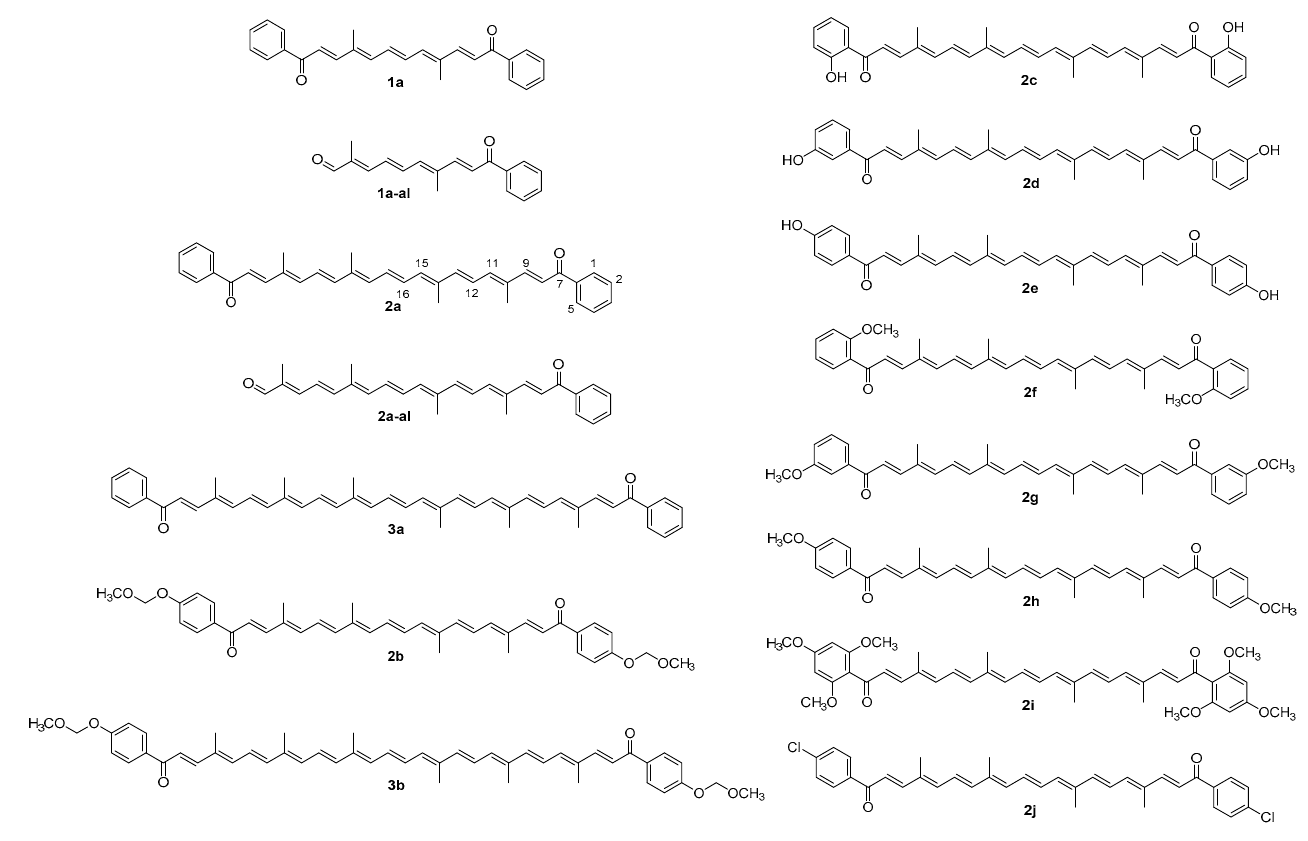
Figure 2. Structures of various novel oxo-carotenoids prepared by the aldol condensation between polyene dials 1 ‐ 3 and acetophenones with different ring substituents. Table 3. The reaction condition and the yield for oxo-carotenoids in Figure 2, their UV maximum absorption wavelength, energy gap between HOMO and LUMO levels, and dihedral angle between benzene ring and polyene chain by DFT {rb3lyp/6–31 g(d,p)} calculation.